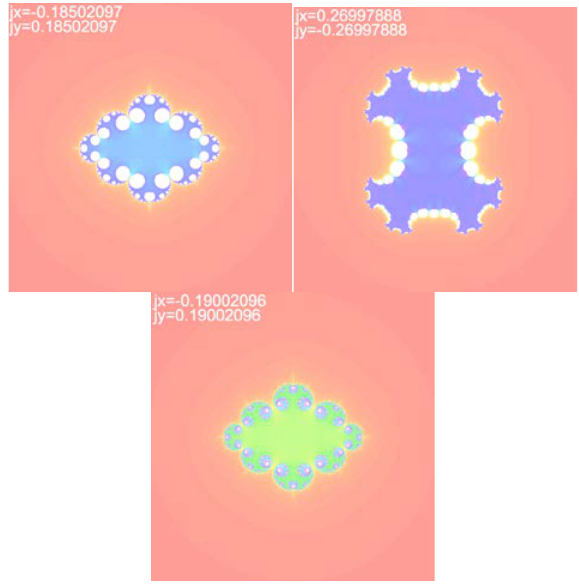
Fig.3. Examples of Julia sets for the “burning ship” map We h ave co nsidered t he i nfluence o f co mplex non- analyticity up on